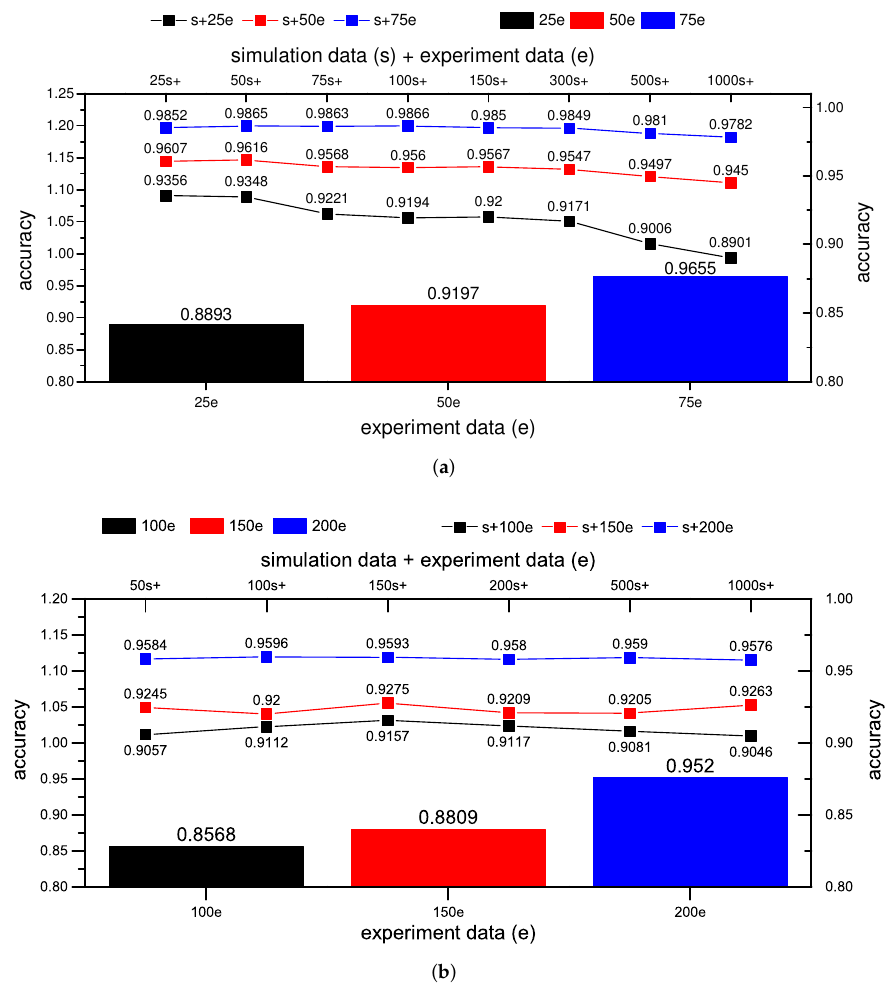
Figure 12. Fault classification under case D. ( a ) 0.021 inches, ( b ) 0.014